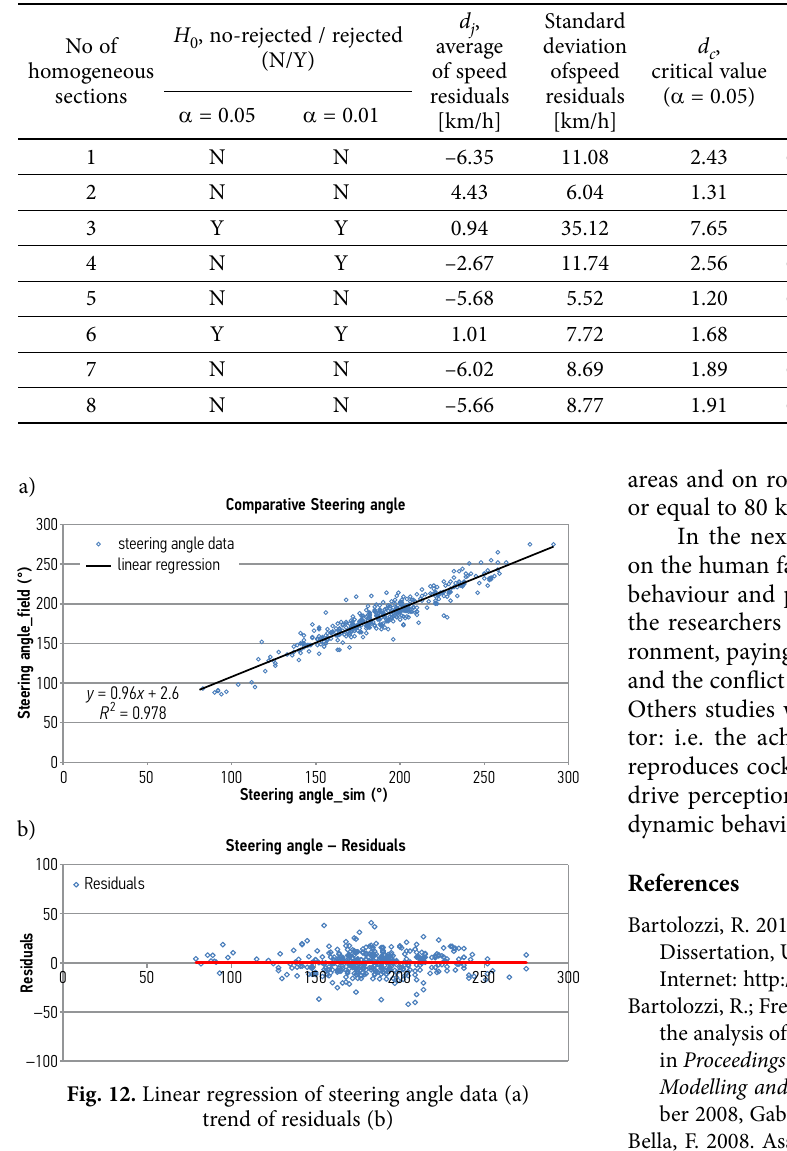
Table 3. Steering angle – summary of results in all locations